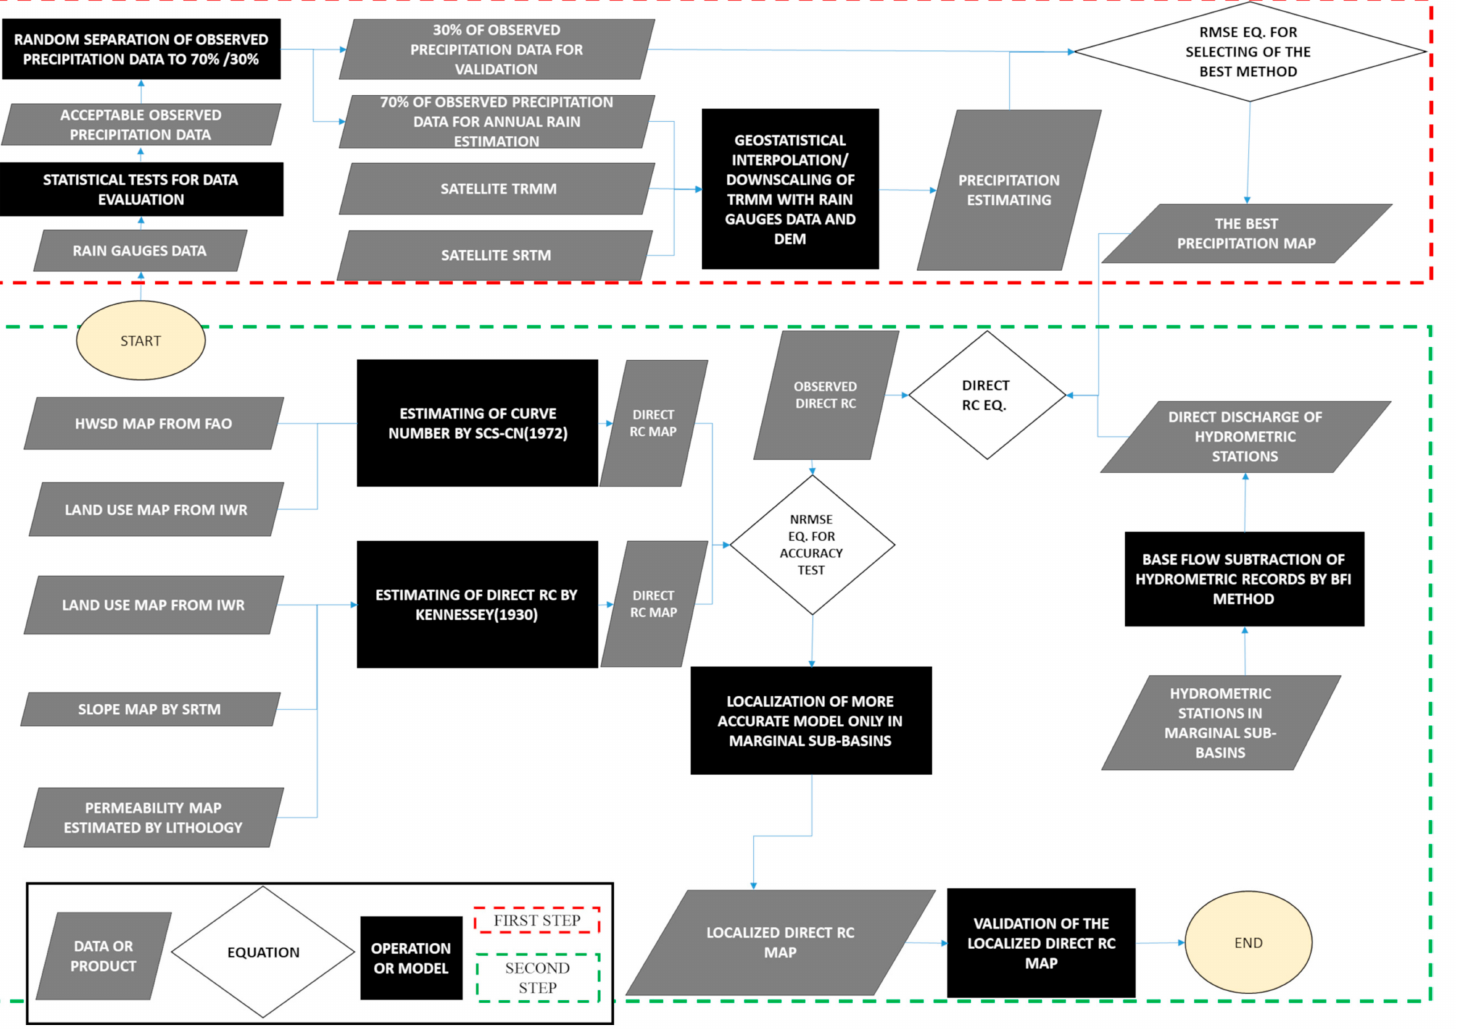
Figure 3. Flowchart showing steps followed in estimation and mapping of annual precipitation and direct runo ff coe ffi cient for Lake Urmia